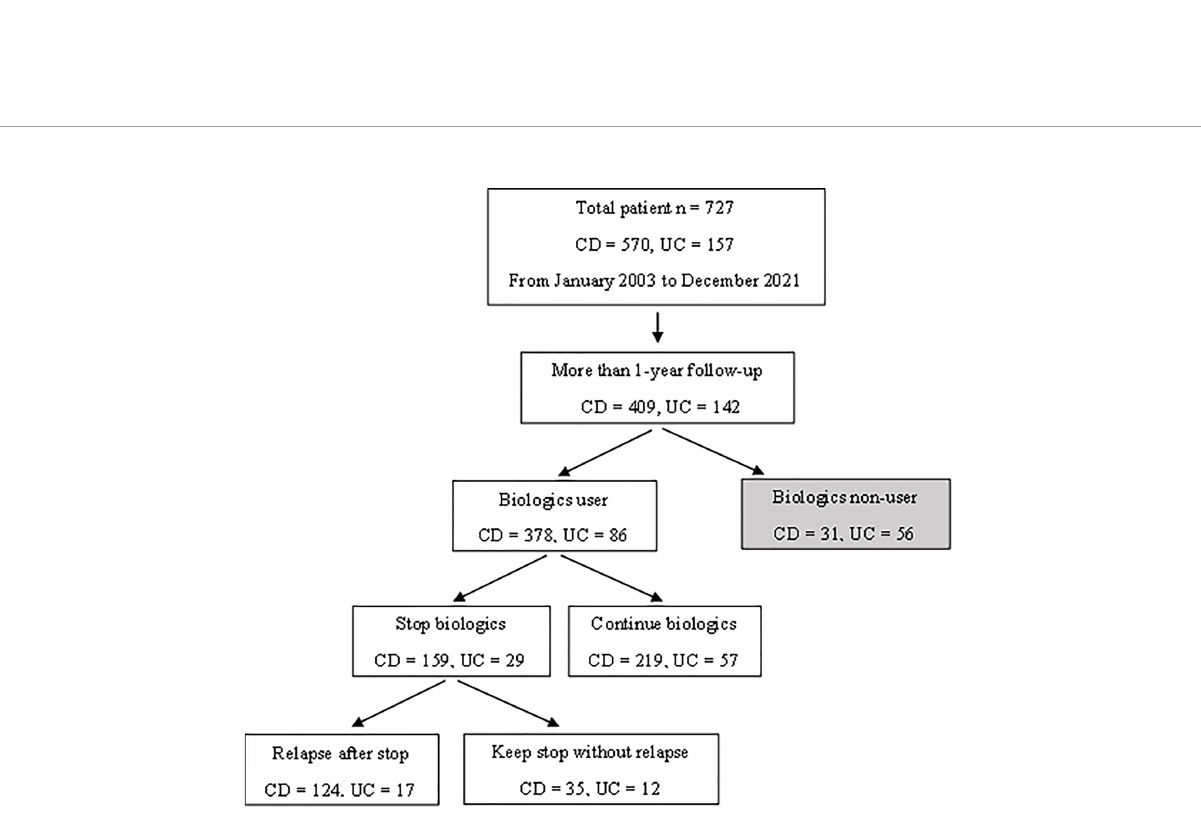
FIGURE 2 Flow chart illustrating the subject selection process and patient